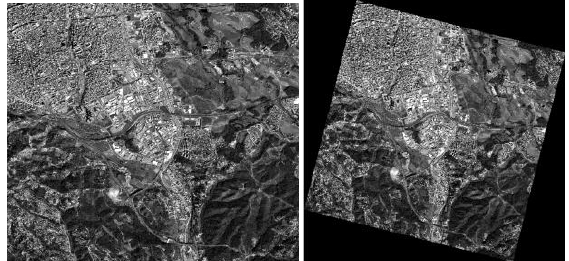
Figure 4. An example of level 1 image (left) and ortho ready image (level 2) (right).